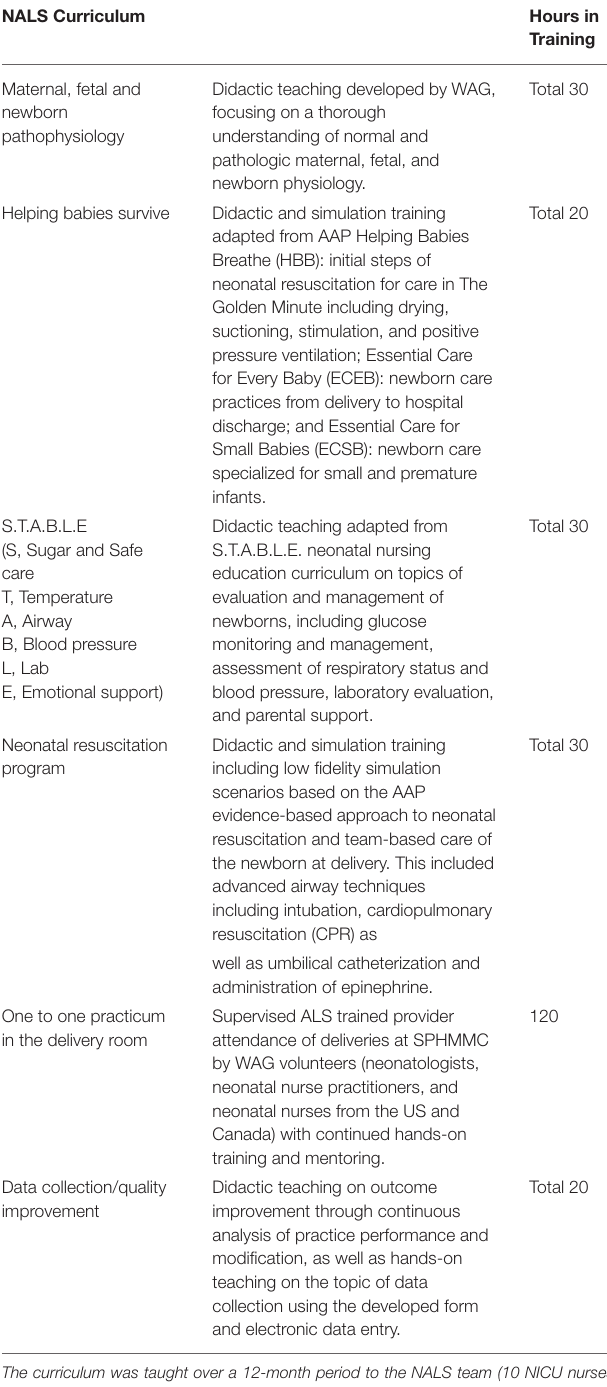
TABLE 1 | NALS curriculum developed to train a dedicated staff to provide newborn stabilization and